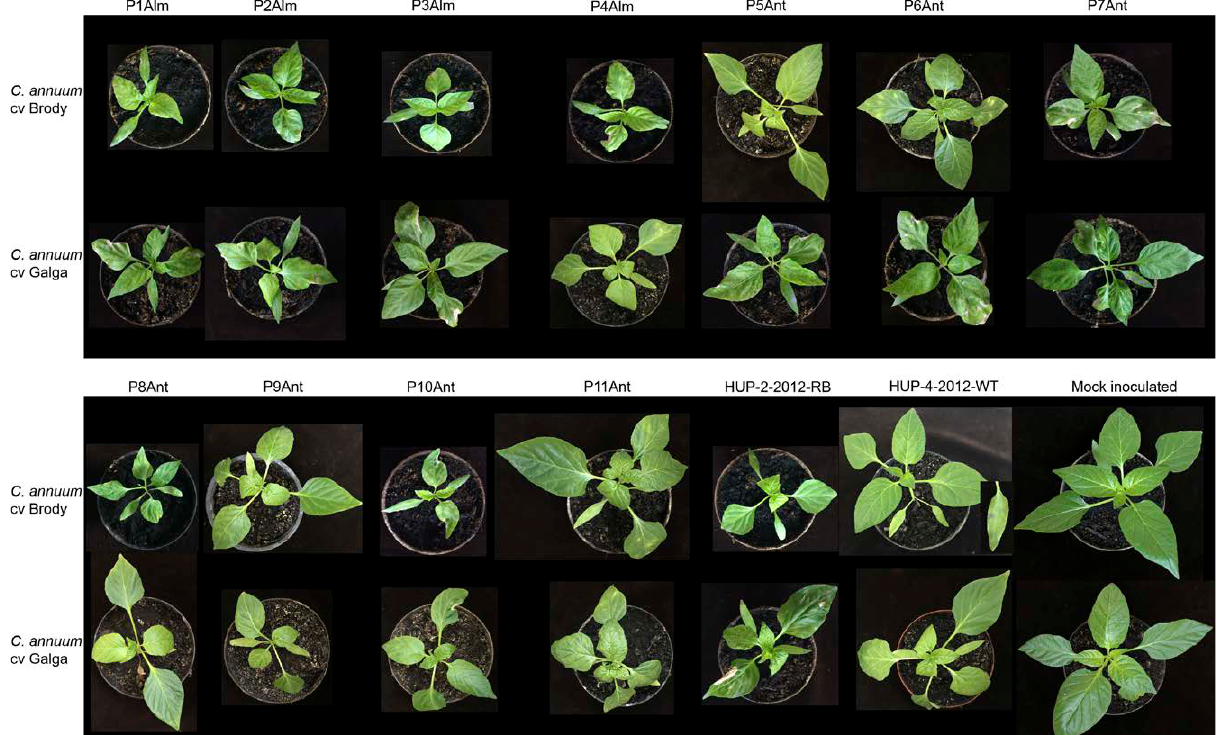
Figure 1. Host symptoms of the isolated TSWV strains mechanically inoculated on resistant ( Capsicum annuum cv. Brody) and susceptible ( C. annuum cv. Galga) pepper